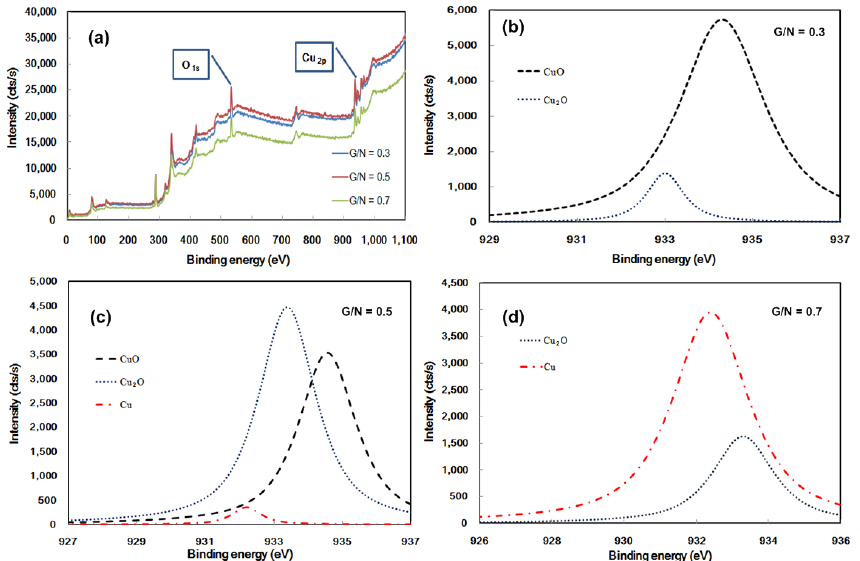
Figure 3. X-ray photoelectron spectroscopy (XPS) wide-scan spectra ( a ) of all samples; deconvolution of XPS spectra of ( b ) (G/N) = 0.3, ( c ) (G/N) = 0.5, and ( d ) (G/N) = 0.7 samples.